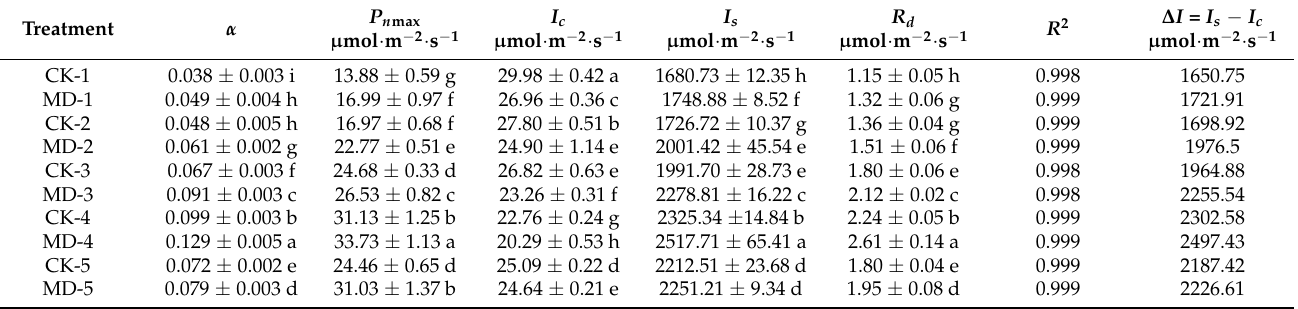
Table 6. Parameters of the spinach light response curve from the modified rectangular hyperbolic